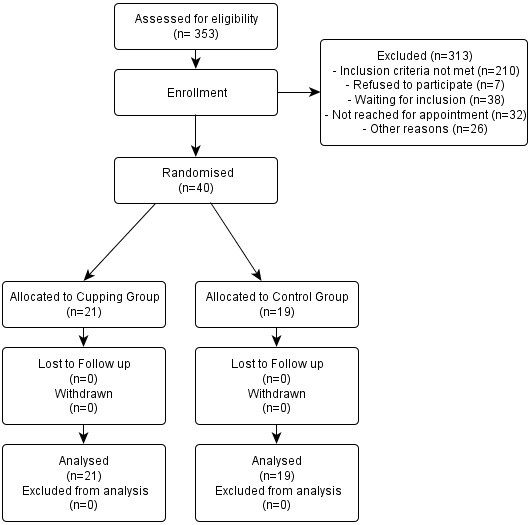
Trial flow chart.